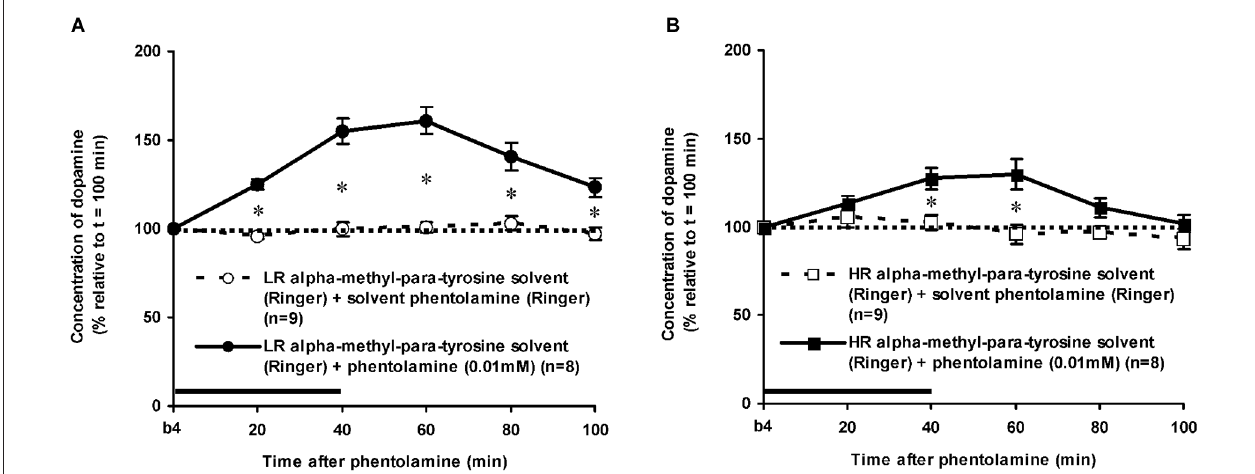
levels expressed as percentage of the sample collected just before PA was infused (basal sample b4 of Figure 3 ). Data are expressed as mean percentage ± SEM. The solid horizontal line represents the infusion time of PA. * Significant DA increase after PA (Student’s t -test).